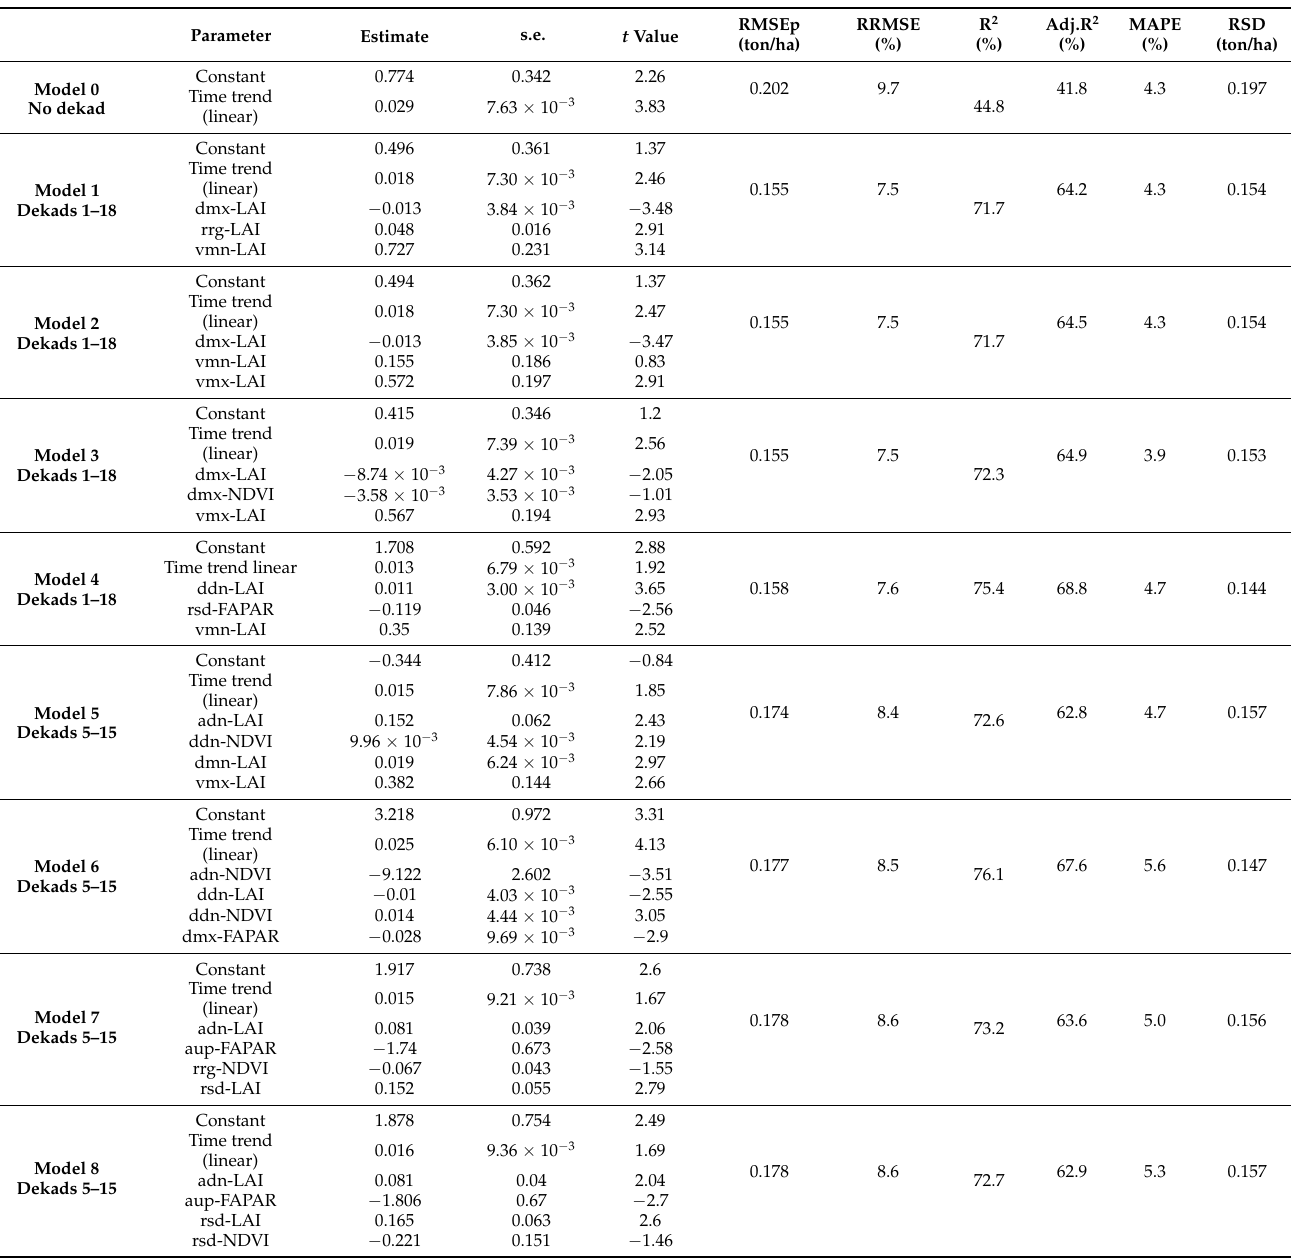
Table 3. Details of the eight best coffee yield models for Dak Lak province based on phenological variables derived from NDVI, FAPAR, and LAI for the 2000–2019 time period, with their related statistical perfomrances. Models 1 to 4 are based on dekads 1 to 18 (January to June), and models 5 to 8 are based on dekads 5 to 15 (mid-March to end of May). Model 0 corresponds to the model achieved with the coffee yield linear time trend